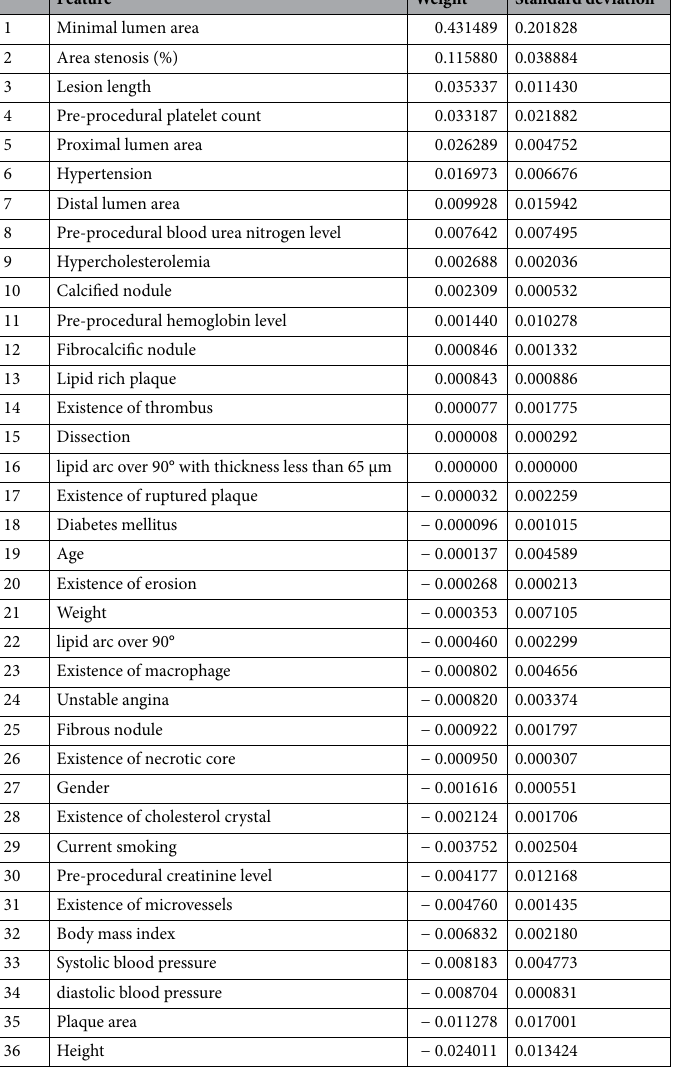
Table 1. List of 36 features, their weight, and standard